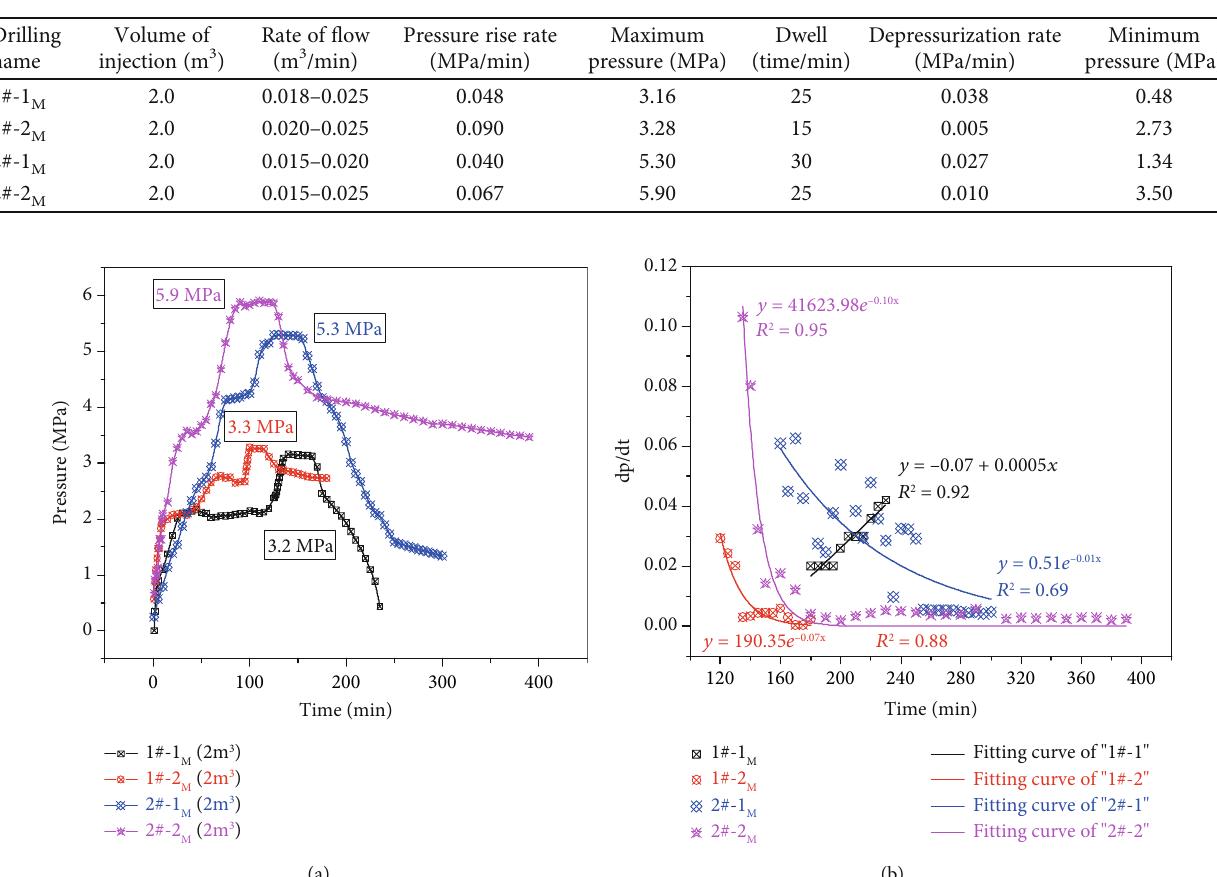
Figure 5: Variation of ori fi ce pressure during low pressure injection. Table 4: Table of medium pressure injection parameters.